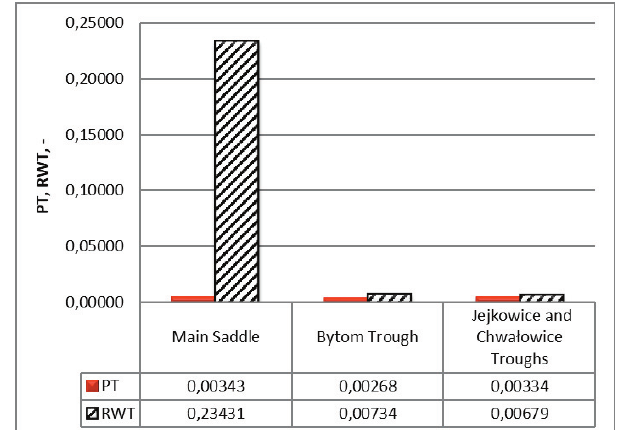
Fig. 5. Distribution of Regional Rockburst Indicators (RWT, –) against Rockburst Probability (PT, –) in different regions of Upper Silesian Coal